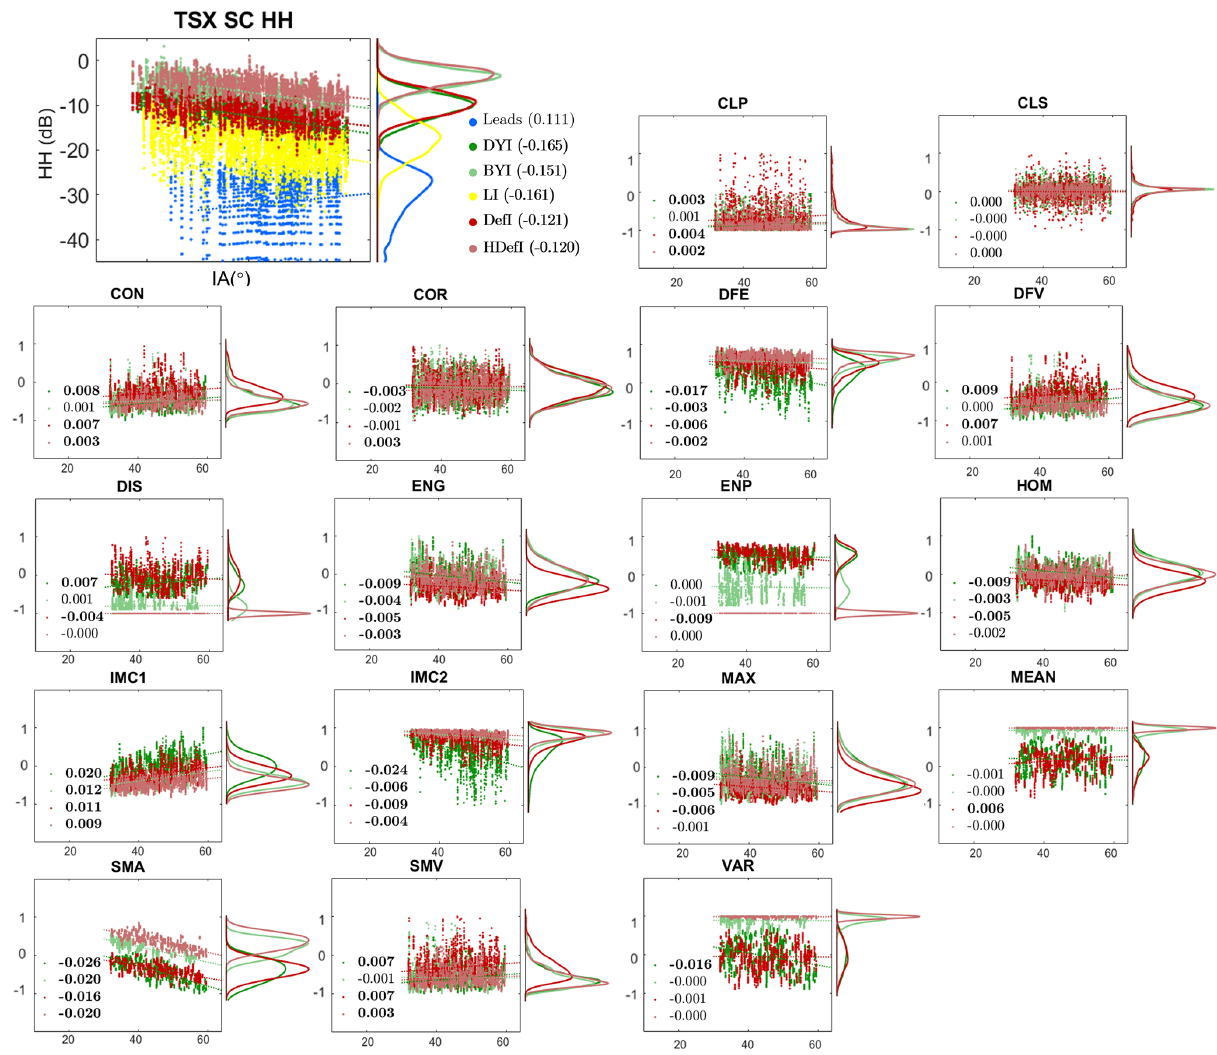
Figure 4. Histograms and scatterplots of TSX SC HH intensities with the IA for the reference polygons (all classes) and of GLCM textures (Table 2) with the IA for the training polygons (difficult class pairs). Slope values of different classes with the IA are also shown, with bold font indicating statistical significance. Values of all texture measures are scaled to the − 1 to 1 range in order to yield comparable slope